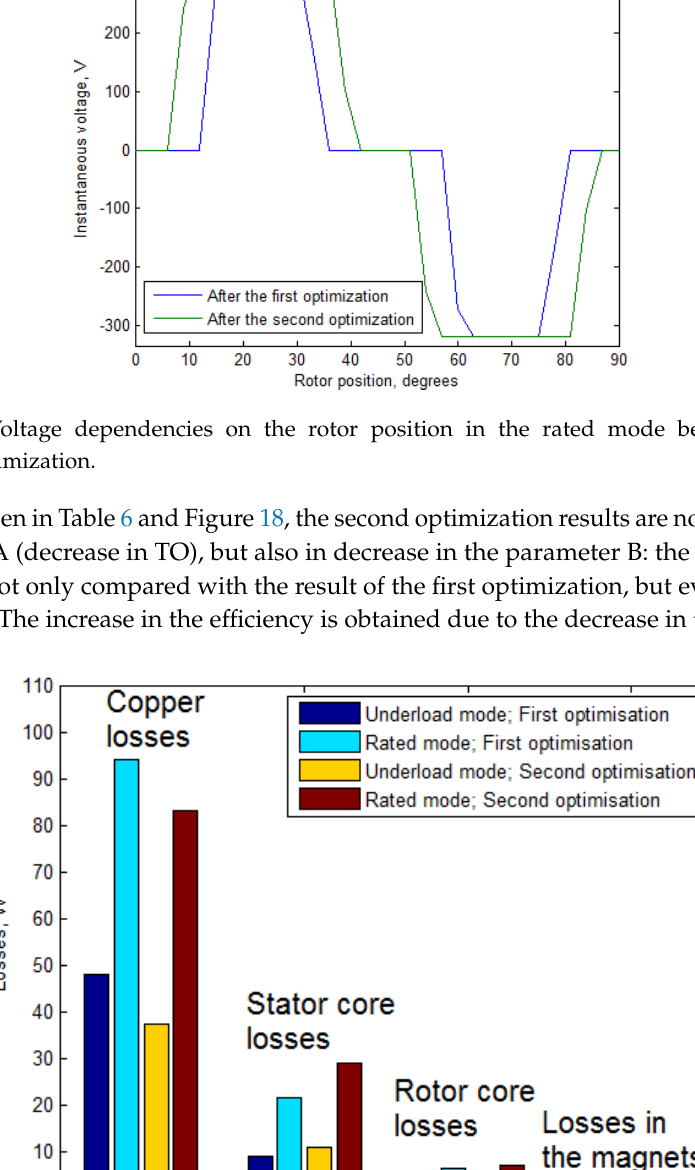
mode 1; ( b ) mode 2.